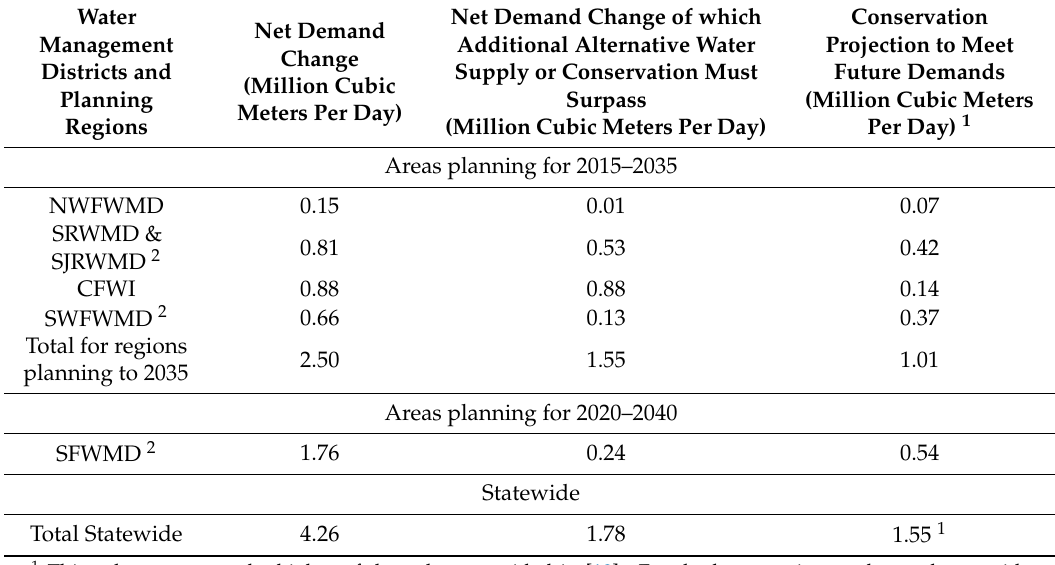
Table 1. Projections of the water demand change, existing water sources, and additional water needed for Florida regions (based